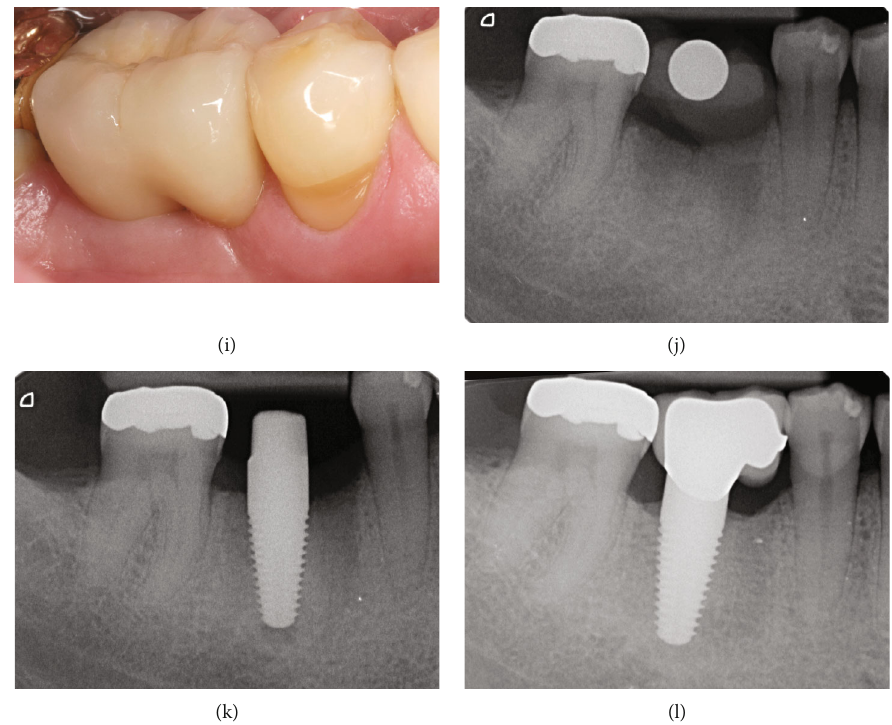
Figure 3: Implantation of one-piece implant (clinical procedure): (a) clinical situation presurgically; (b) elevation of full-thickness fl ap with preservation of peripheral periodontium at adjacent teeth; (c) implant bed preparation, predrilling instrument; (d) processed implantation site using drilling protocol; (e) placement of one-piece implant with spatial orientation aligned to the natural dentition; (f) apical repositioned and sutured fl ap; (g) clinical situation one week after surgery; (h) clinical situation 12 weeks after surgery; (i) single crown prosthetic restoration with mesial pontic design; (j) presurgical radiographic control, calibration ball for planning of implantation; (k) postsurgical radiograph taken directly after implant placement; (l) radiographic control nine years after